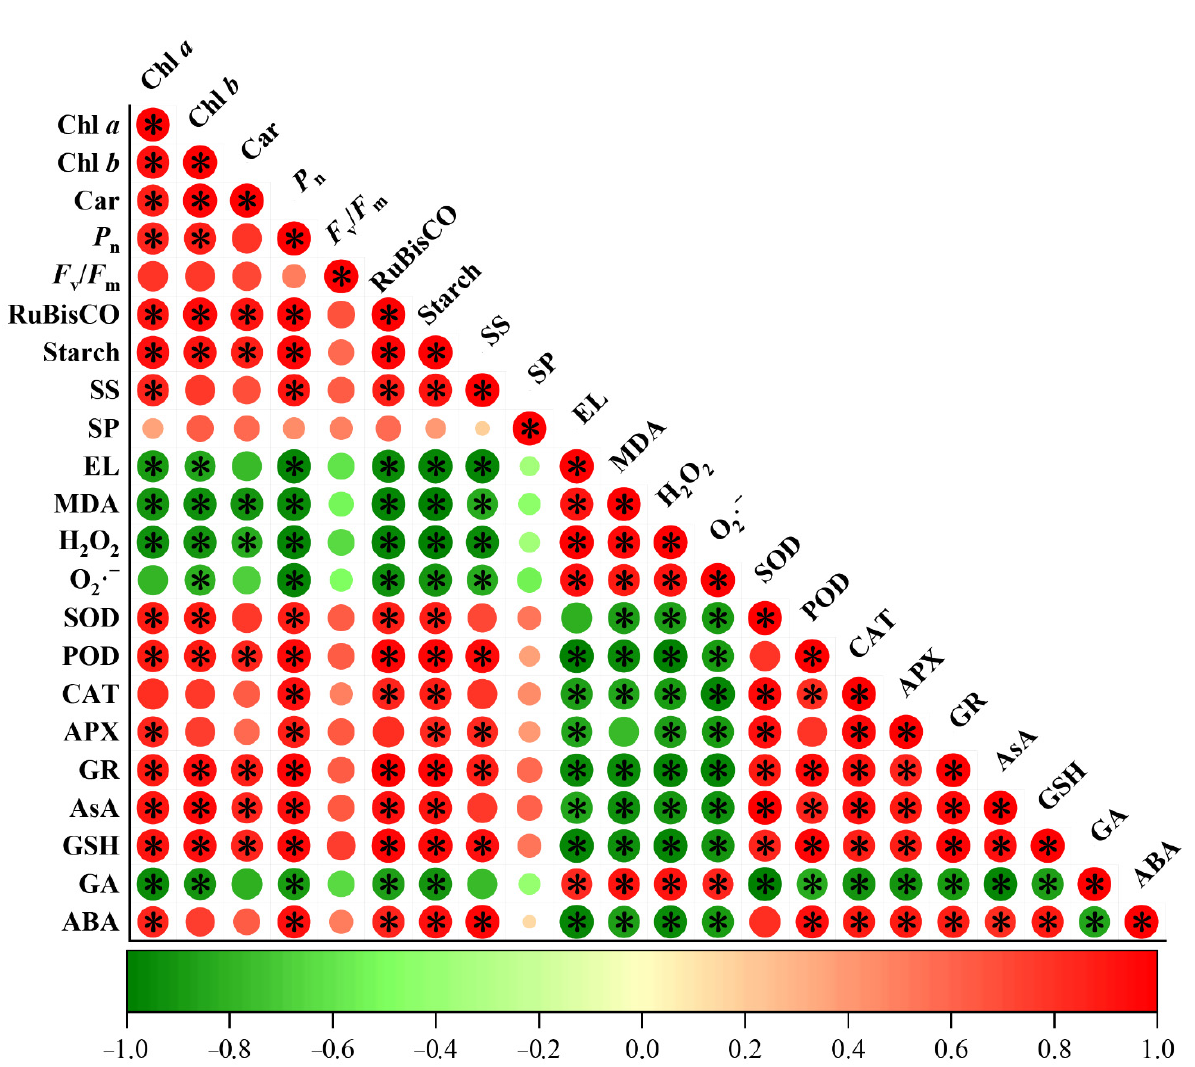
Figure 9. Pearson’s correlation matrix among photosynthesis, antioxidant activity, and phyto- hormone attributes under LL stress with and without PBZ application. Correlations are dis- played by specific colors. * indicates significant differences at p < 0.05. Chl a = chlorophyll a , Chl b = chlorophyll b , Car = carotenoid, P n = Net photosynthetic rate, F v / F m = maximum quan- tum yield of photosystem II photochemistry, SS = soluble sugar, SP = soluble protein, EL = elec- trolyte leakage, MDA = malondialdehyde, H 2 O 2 = hydrogen peroxide, O 2 · − = superoxide radi- cal, SOD = superoxide dismutase, POD = peroxidase, CAT = catalase, APX = ascorbate peroxidase, GR = glutathione reductase, AsA = ascorbic acid, GSH = reduced glutathione, GA = gibberellic acid, ABA = abscisic